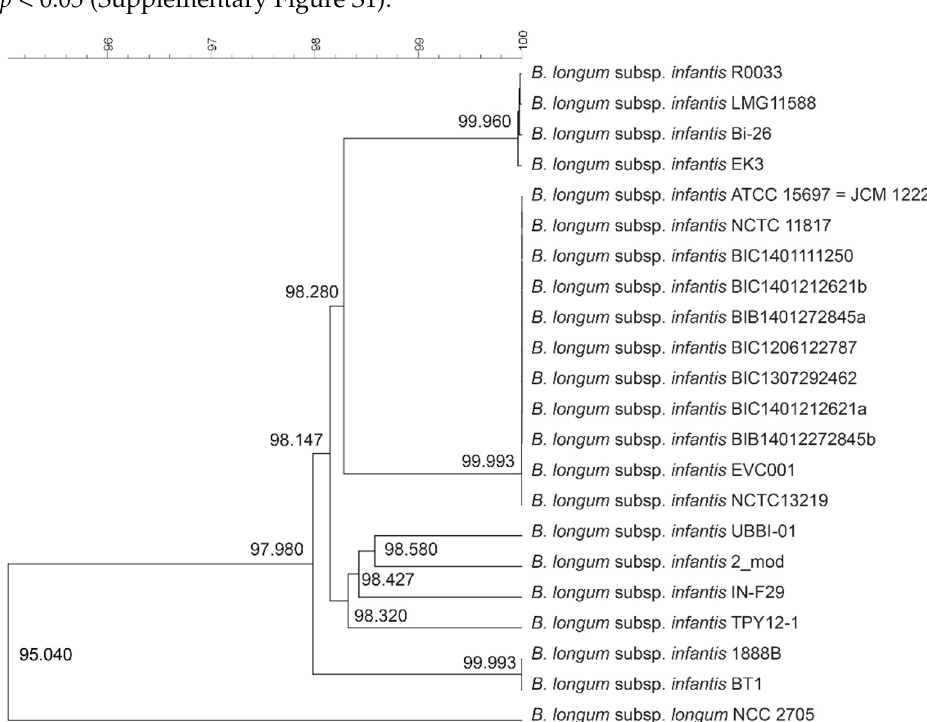
Figure 1. Whole genome based phylogenetic UPGMA tree of publicly available B. longum subsp. infantis strains. The genome of B. longum subsp. longum NCC 2705 was used as an outlier. Average Nucleotide Identity percentage (% ANI) is depicted at each branch node.